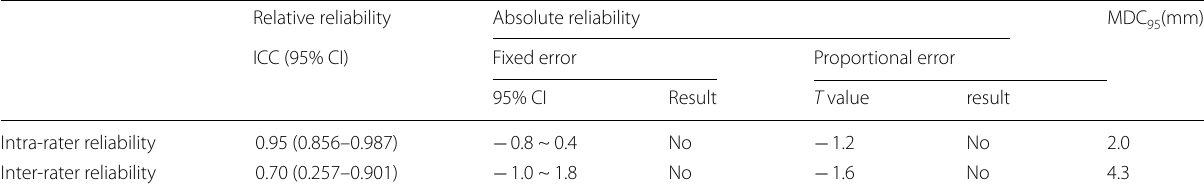
ICC intraclass correlation coefficient, CI confidence interval, MDC95 minimal detectable change with 95% CI